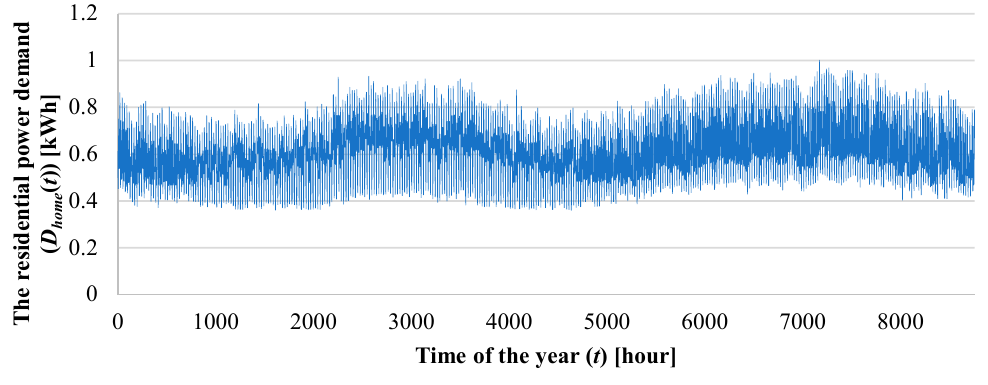
Figure 5. Residential power demand.